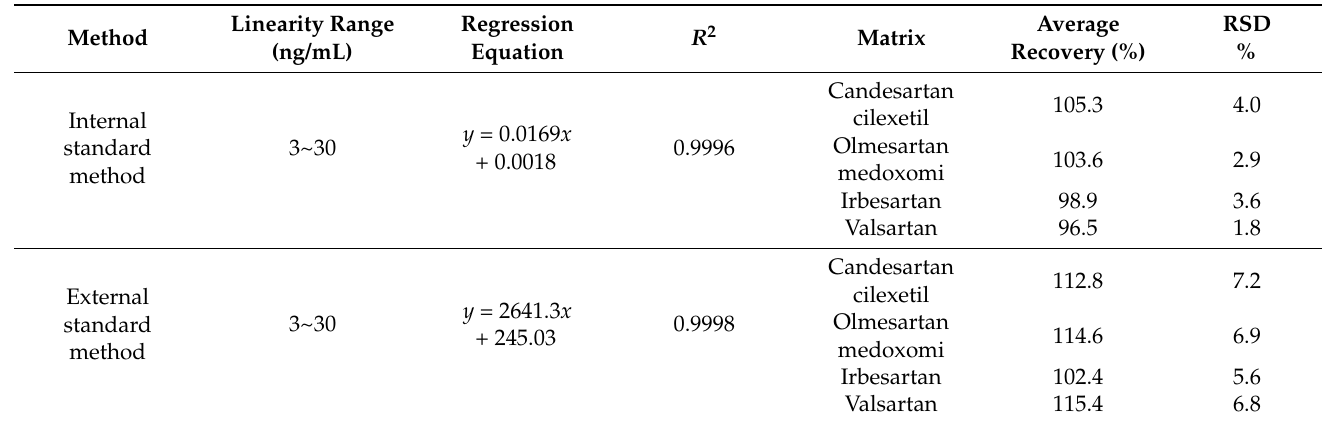
Table 2. Recoveries and RSD values of NMBA in sartan substances through using internal and external standard